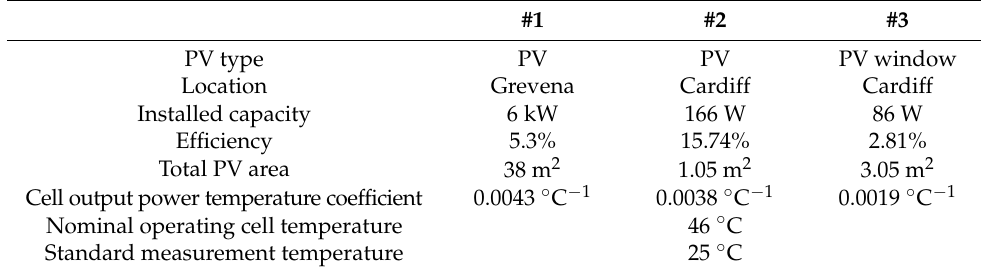
Table 3. Technical specifications for the PV modules